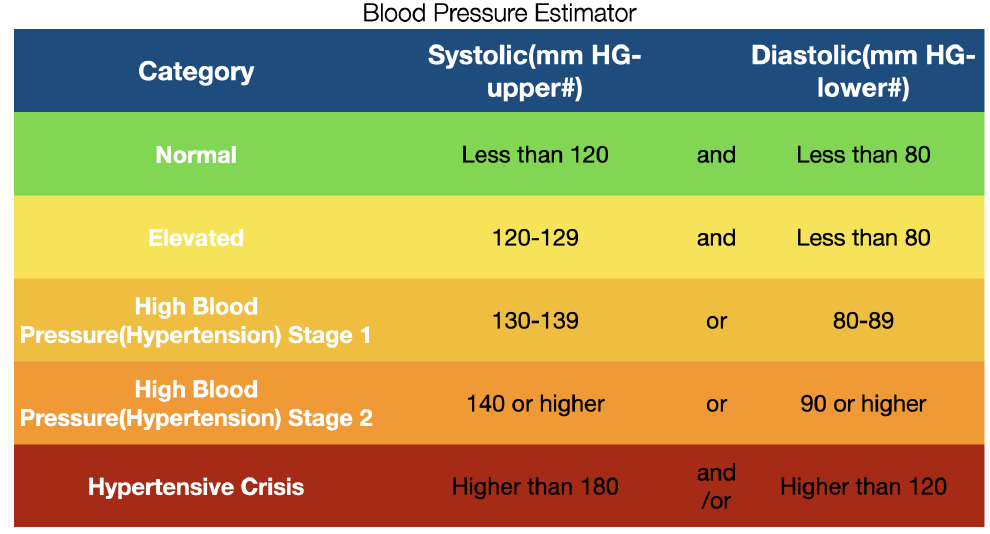
Figure 3. Blood pressure